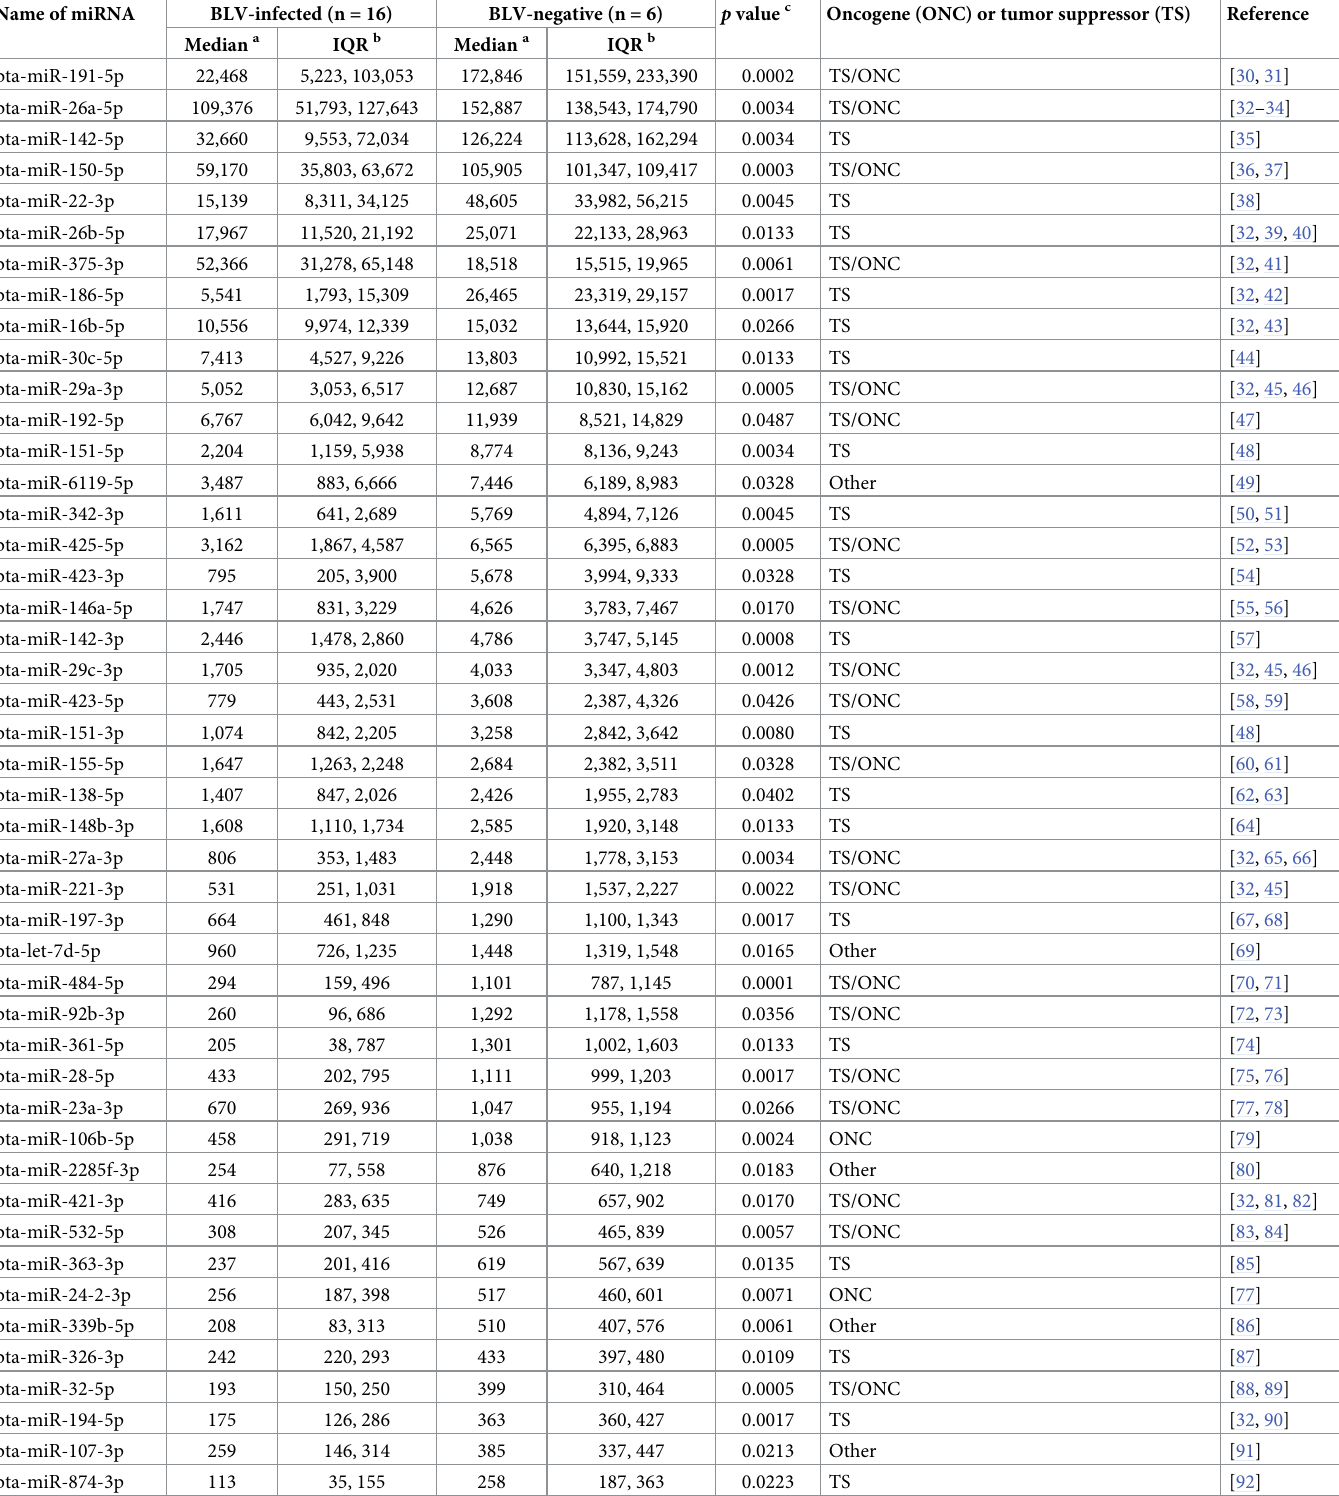
Table 3. Comparison of bovine miRNA (bta-miRNAs) sequencing reads between BLV positive and BLV negative cattle. Name of